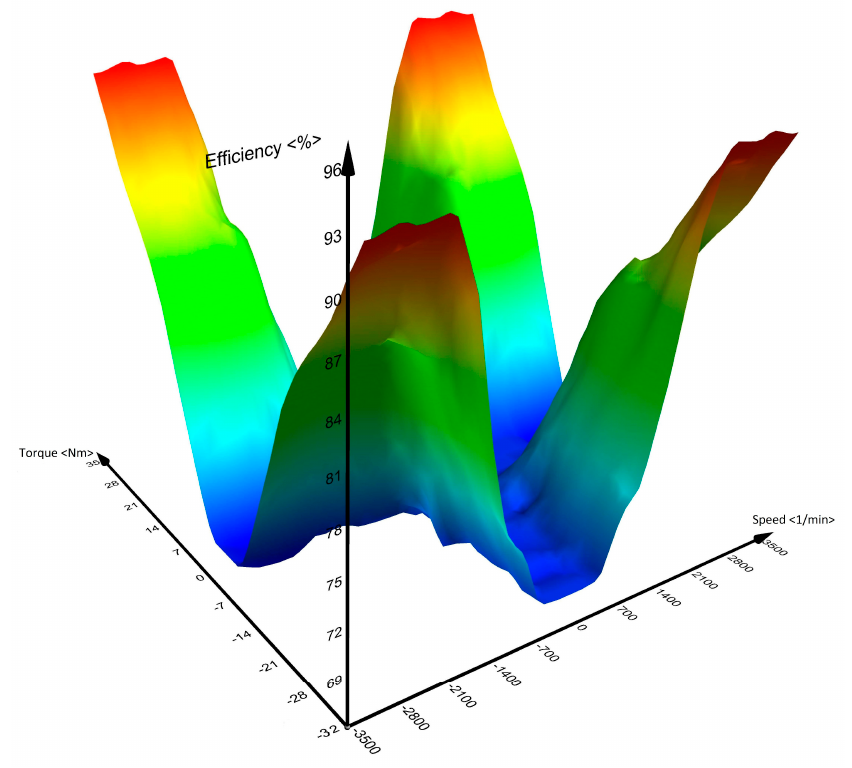
Figure 13. Torque and efficiency curve of electric motor HPQ3-48.